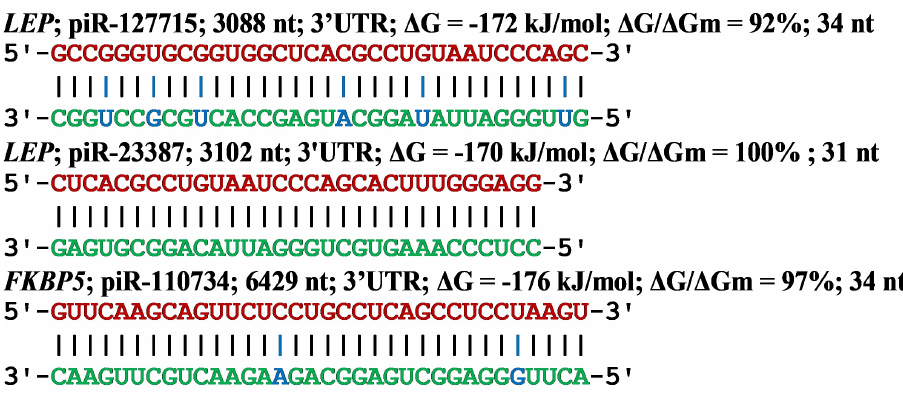
Figure 2. Localization of piRNA BSs clusters in the gRNA of the Omicron variant of SARS ‐ CoV ‐ 2. The overlap of the nucleotide sequences of piRNA BSs in gRNA leads to the compe ‐ tition of different piRNAs while suppressing the start of the process of translation of coro ‐ navirus proteins. Given that the genes encoding these piRNAs can be located in different parts of the human genome, in the case of mutations that disrupt the synthesis of one of these piRNAs, the body will retain the ability to defend itself against the coronavirus. In addition to the above four piRNAs interacting with gRNA with free energy from − 130 kJ/mol and higher, in the 5 ′ UTR BSs cluster at position 156 nt, piR ‐ 2388809 also bound with a Δ G value of − 132 kJ/mol (Table S1). Therefore, by synthesizing endogenous piR ‐ NAs, a human acquires the ability to protect themself from a deadly pathogen.